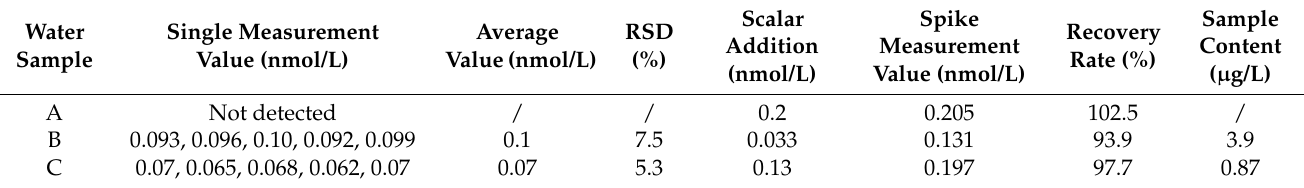
Table 3. Results of sample